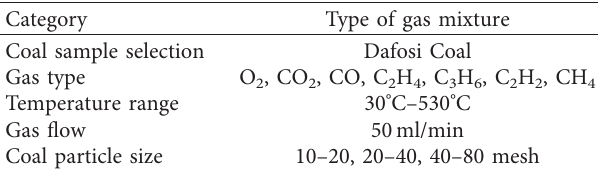
Table 2: Experimental